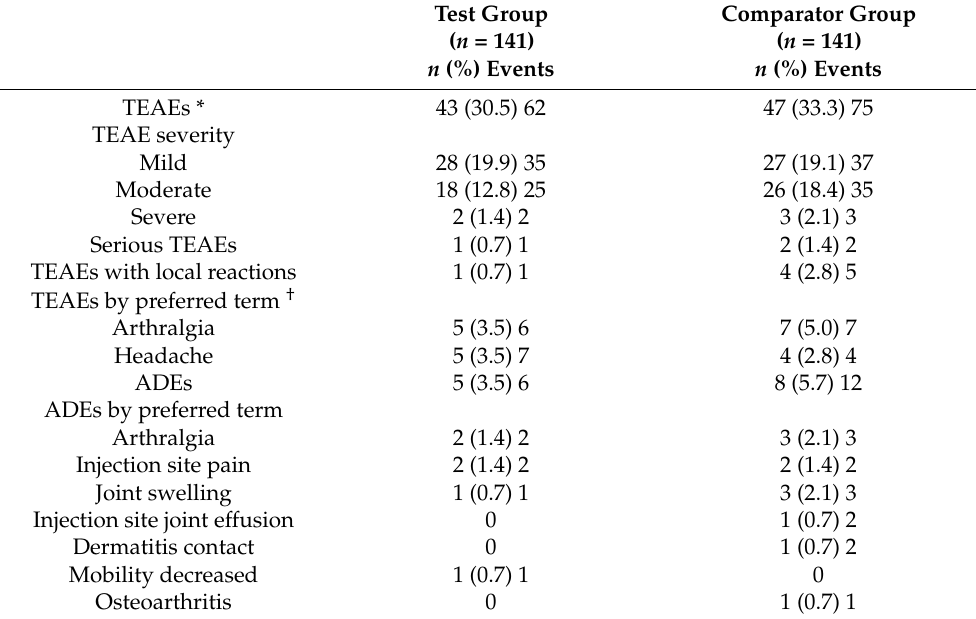
Table 3. Adverse events (safety